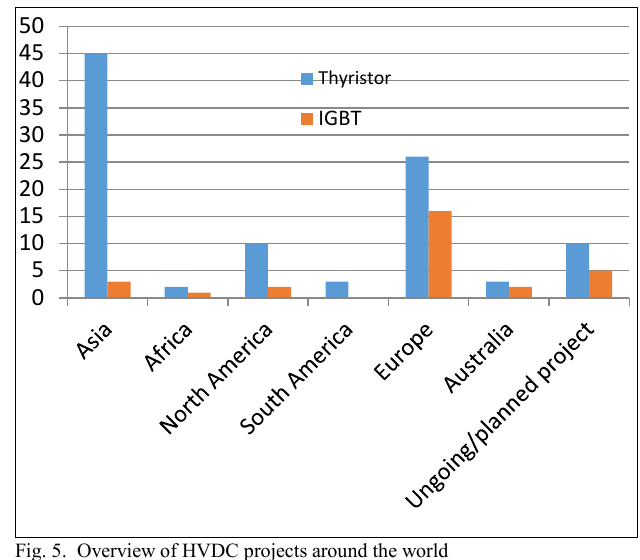
Fig. 5. Overview of HVDC projects around the world